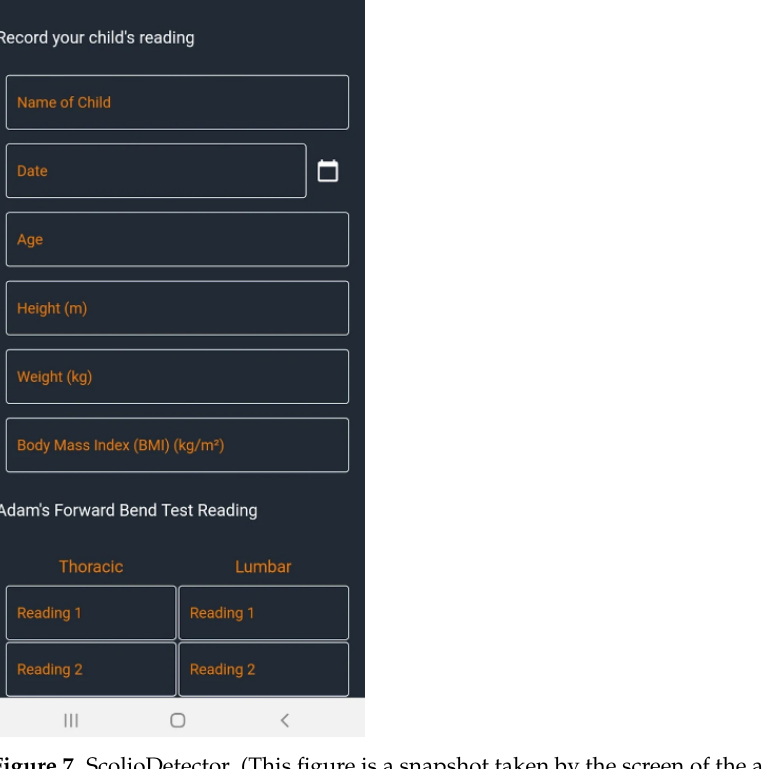
Figure 7. ScolioDetector. (This figure is a snapshot taken by the screen of the